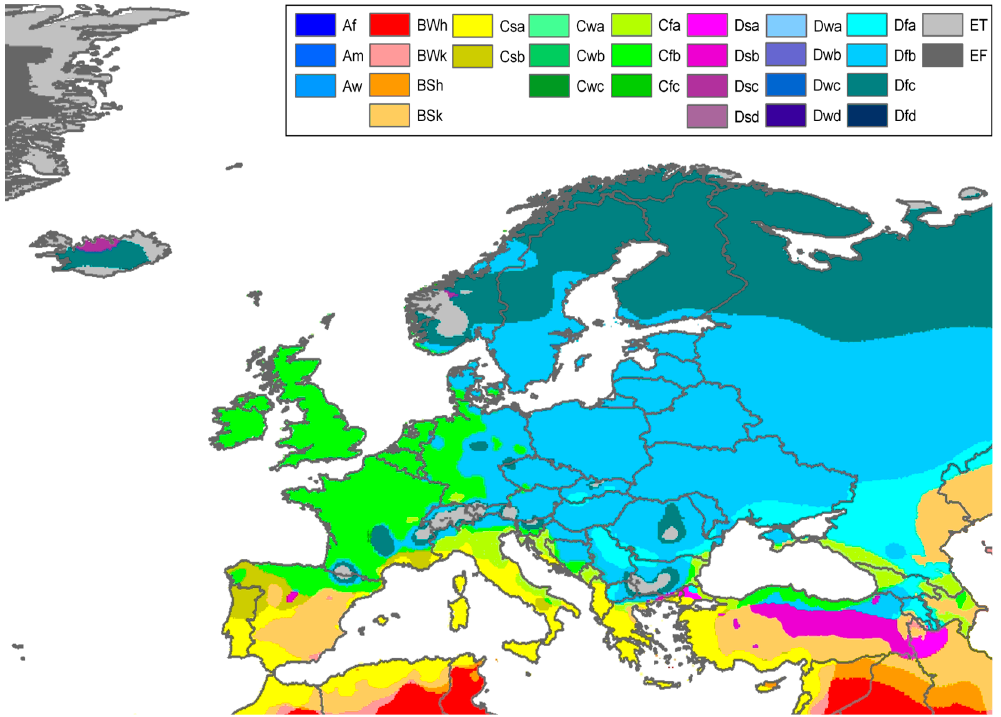
Figure 1. European map of the Köppen–Geiger climate classification [32].